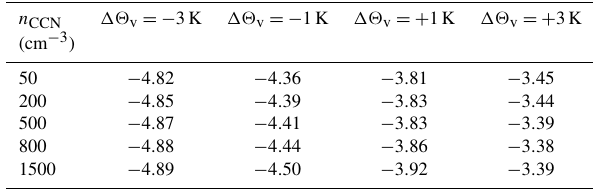
Table A6. Temperature sensitivity (in %K − 1 ) of the condensation ratio CR for all n CCN values.